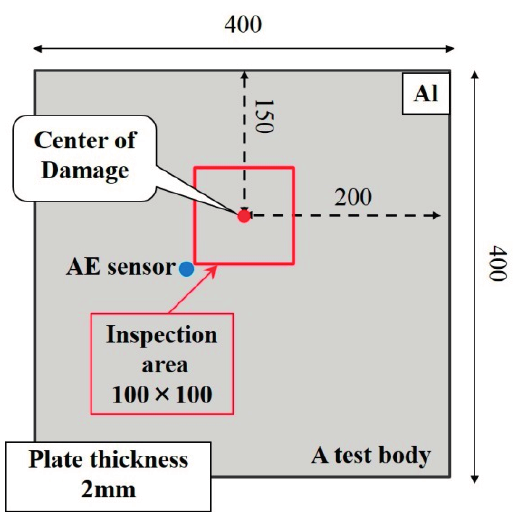
Figure 4. Schematic of an aluminum plate and AE sensor in the experiments (unit: